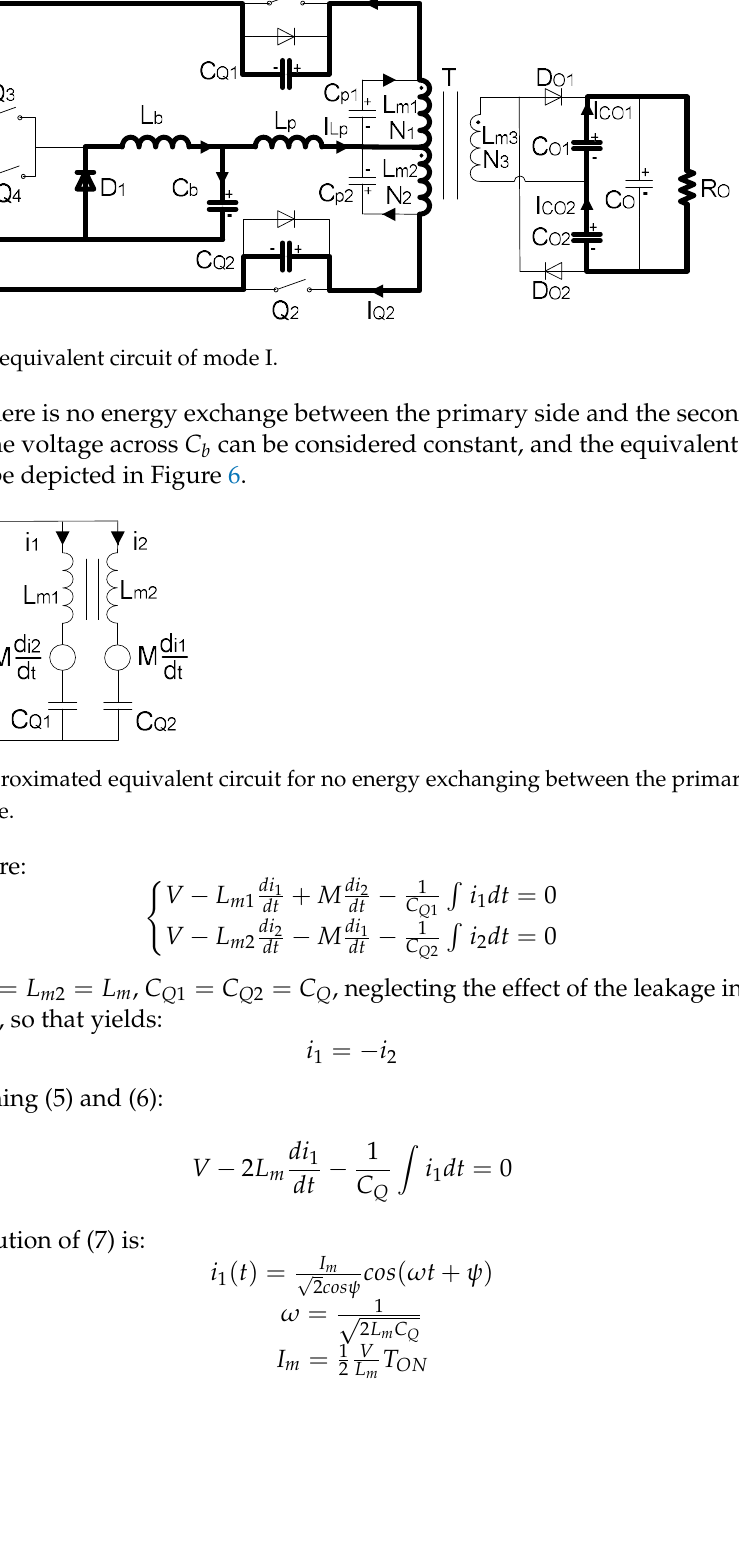
I CO1 I CO2 Figure 7. Equivalent circuit of mode II. Mode III [ 𝑡 (cid:2870) , 𝑡 (cid:2871) ]: The equivalent circuit of mode III is depicted in Figure 8.When the resonance on the primary side of the transformer finishes, the current through 𝐶 (cid:3018)(cid:2869) , 𝐶 (cid:3018)(cid:2870) ,